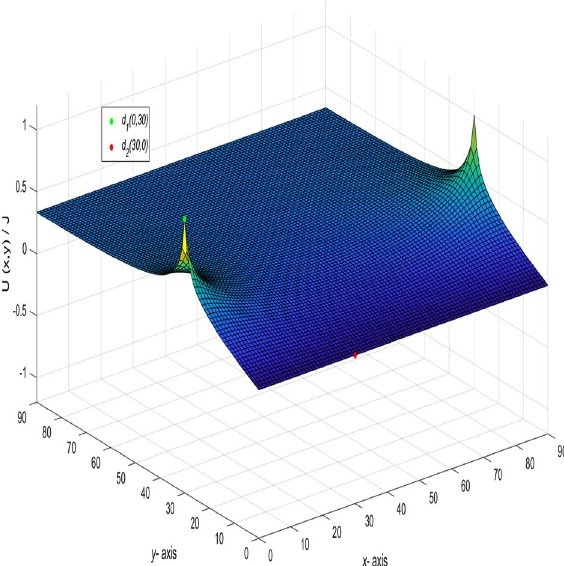
90 ( x , y )/ J in Eq. (42). ×